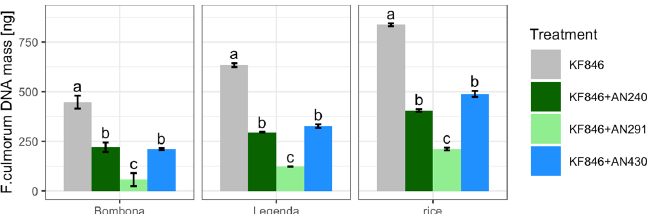
Figure 11. Biomass of F. culmorum determined by qPCR in culture/co-culture on rice solid medium and in wheat kernels (Bombona, Legenda) inoculated with the pathogen (KF846, control) and inoculated with both the pathogen (KF846) and the antagonist (AN240 or AN291 or AN430). Letters indicate significance groups within the row (for each yield parameter) according to Tukey’s test at 0.05.